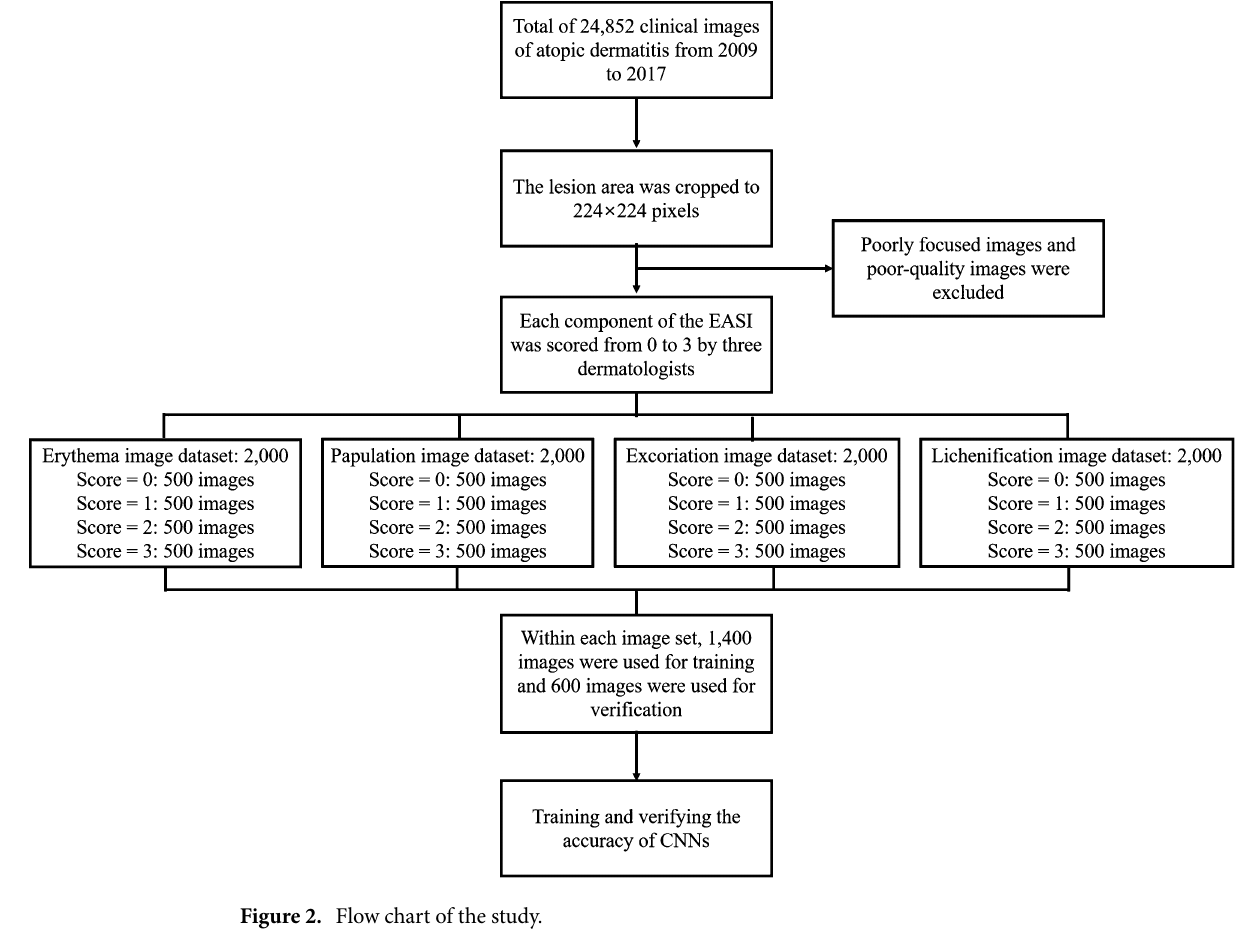
Figure 2. Flow chart of the